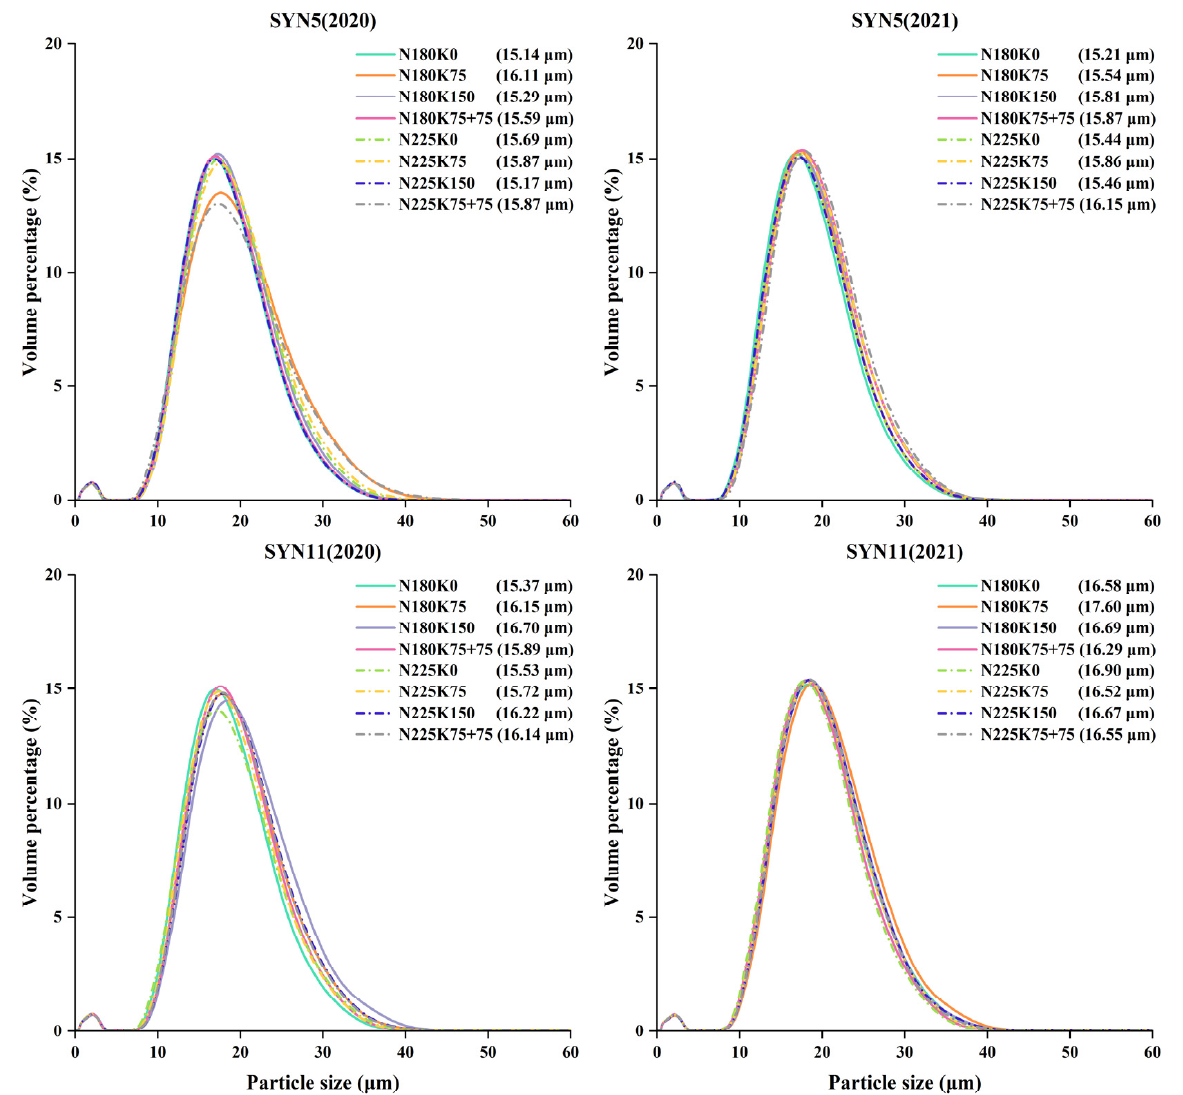
Figure 1. The volume distributions of waxy maize starch granules under different fertilization treatments. N180, N225: application 180 and 225 kg N ha − 1 ; K0, K75 and K150: application 0, 75 and 150 kg K 2 O ha − 1 at sowing date; K75 + 75: application 75 kg K 2 O ha − 1 at sowing date and jointing stage